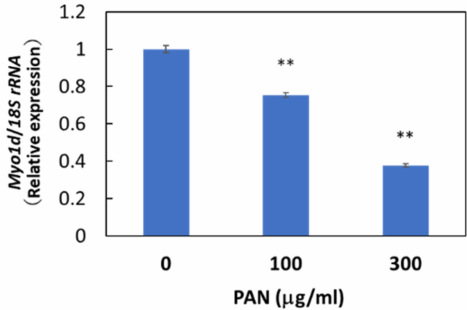
Figure 5. Myo1d mRNA levels in PAN-treated E11 cells. E11 cells were treated with 0–300 µ g/mL PAN. Values were normalized relative to 18S rRNA expression. The relative expression level of Myo1d mRNA at 0 µ g/mL PAN was given arbitrary value of 1. ** p < 0.01 versus 0 µ g/mL PAN. Data represent the means ± SD (n =